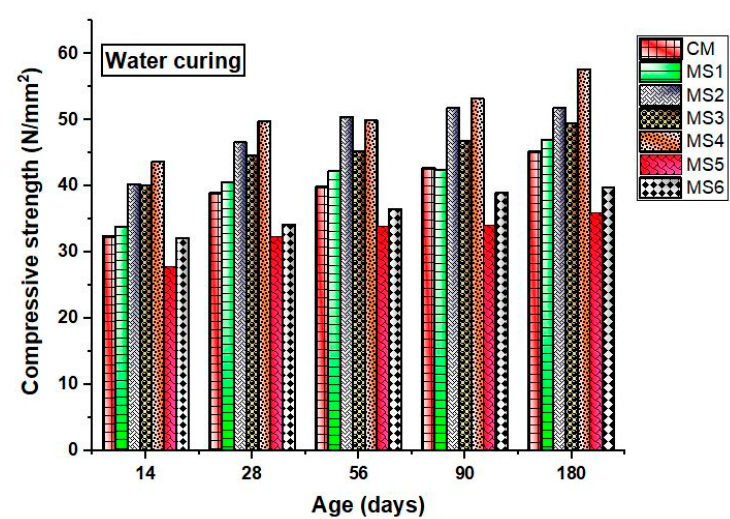
Figure 5. Compressive strength of the concrete mixes in water curing at various ages.